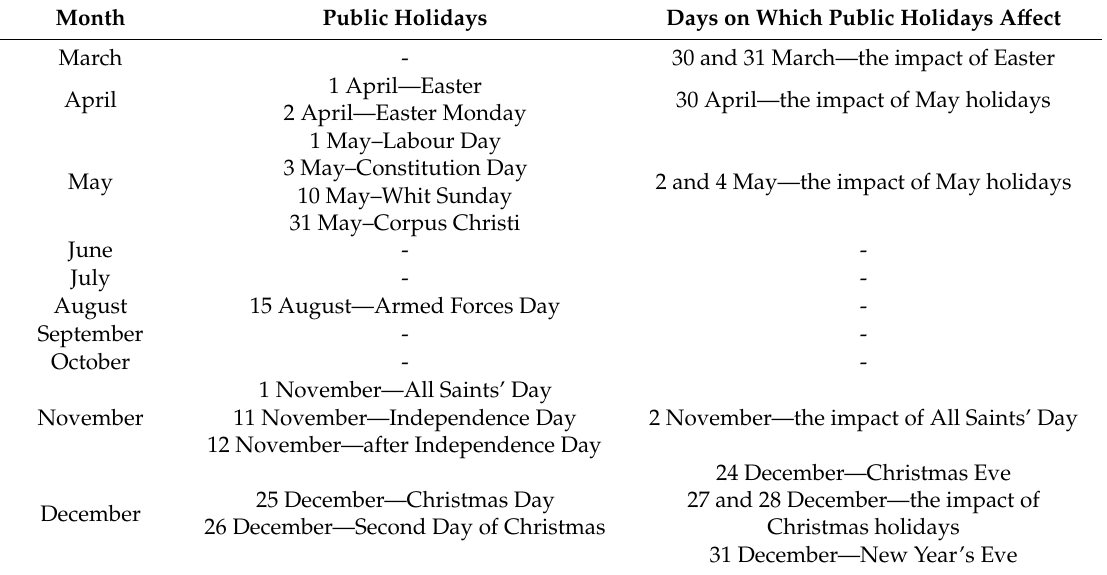
Table 3. Public holidays and days on which public holidays a ff ect, which were not included in the